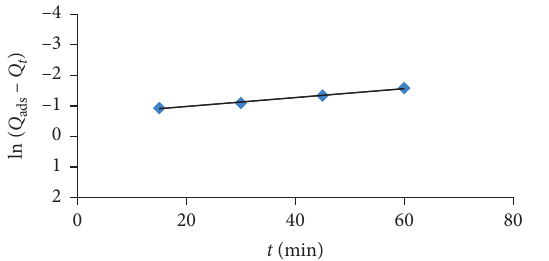
Figure 9: Pseudo-first-order model related to the adsorption kinetics of phenol on the adsorbent support (Lagergren model). Table 4: Parameters of the graphical representation of the Largergren equation for the adsorption kinetics of phenol. R 2 K 2 (min − 1 ) Experimental Q e (mg · g − 1 )